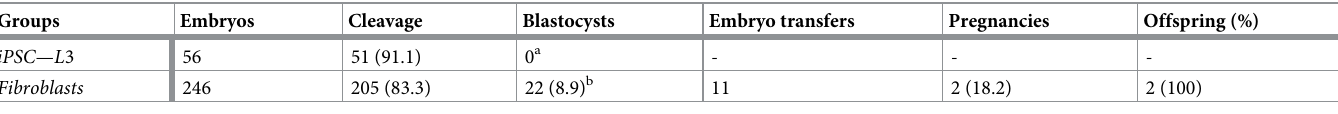
Table 2. Equine cloning using L3-iPSCs as nuclear donors.